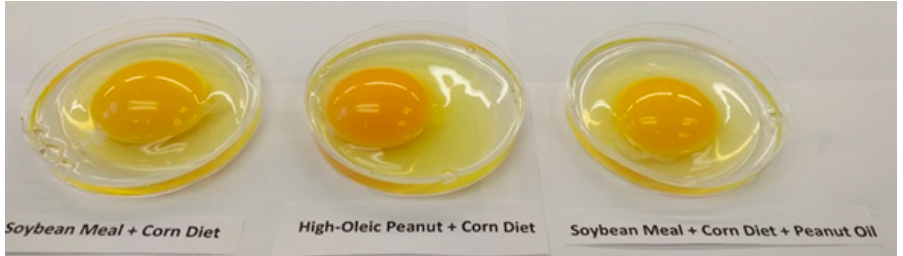
Figure 1. Representative images of yolk color within whole egg samples from each treatment group at week 8 of the feeding trial. Ninety-nine brown Leghorn (57 week of lay) hens were fed one of three isonitrogenous (18% crude protein) diets ad libitum for 8 weeks. At 8-weeks, one whole egg was randomly selected for this photograph as a representative of yolk color observations seen on the day of egg processing with 12 eggs per treatment. This image is not representative of any other egg quality parameters measured. Treatments: Control = conventional soybean meal and corn mash diet, HOPN = 20% unblanched high-oleic peanut + corn diet, OA = control diet supplemented with